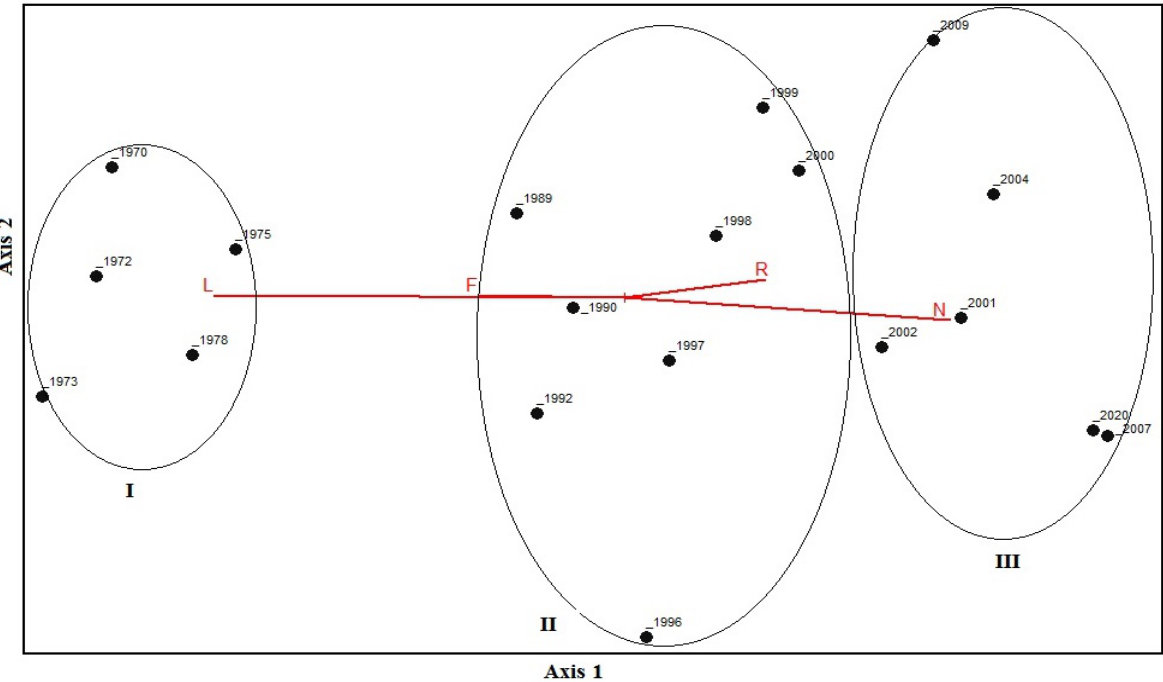
Figure 2. NMS ordination plot for the distribution of relevés over the 50 years of studies (from 1970 to 2020). Roman numerals indicate the ‘drainage periods’ (I: 1970–1978; II: 1989–2000; III: 2001–2020. Vectors of environmental variables are shown in red and labelled L: light; F: soil moisture; R: soil acidity; N: mineral nitrogen content in